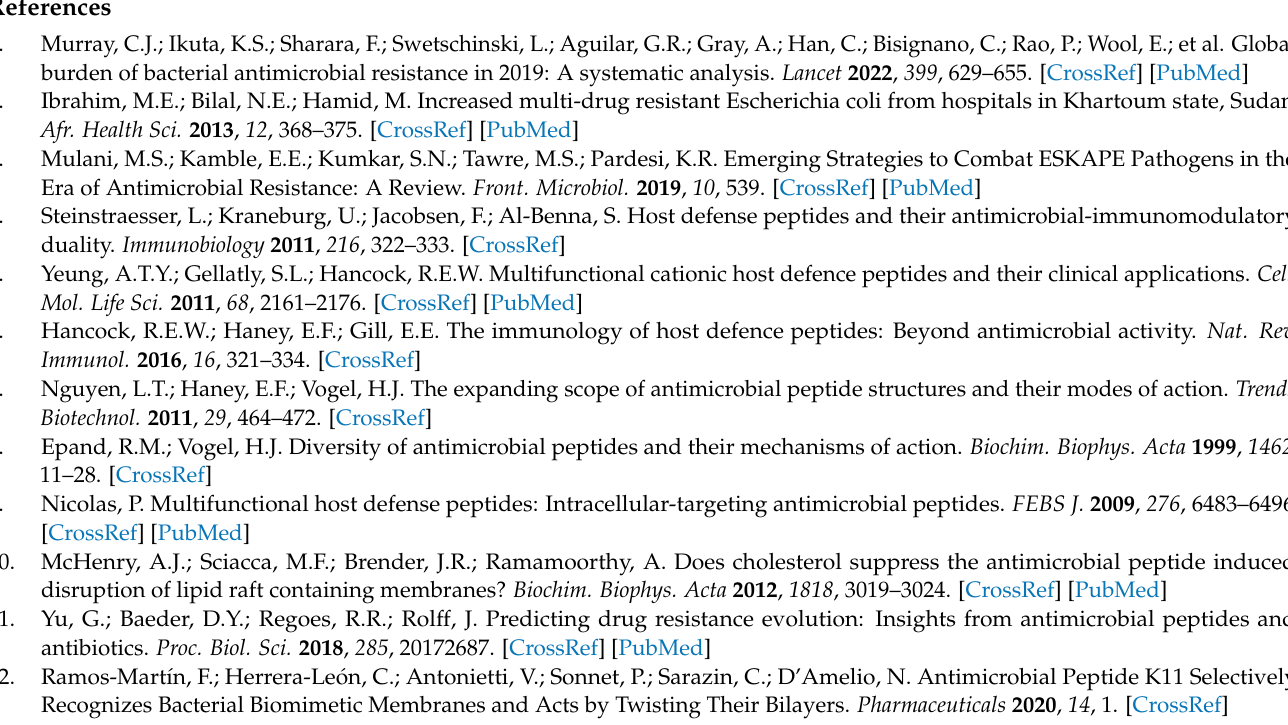
Figure S2: Chemical Shift Index of crabrolin21 in bicelles; Figure S3: Observed NOEs for crabrolin21 in TFE; Figure S4: Ramachandran plot for crabrolin21 in TFE; and Figure S5: NMR distance constraints for crabrolin21 in TFE. Table S1: Summary of restraints and structure quality factors of the determined family of conformations for crabrolin21 in